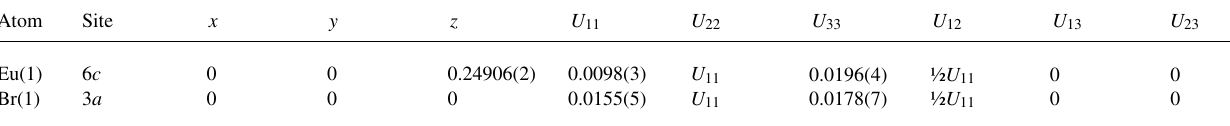
Table 3. Atomic coordinates and displacement parameters (in Å 2 ) for the composition Eu 2 [BN 2 ]Br .